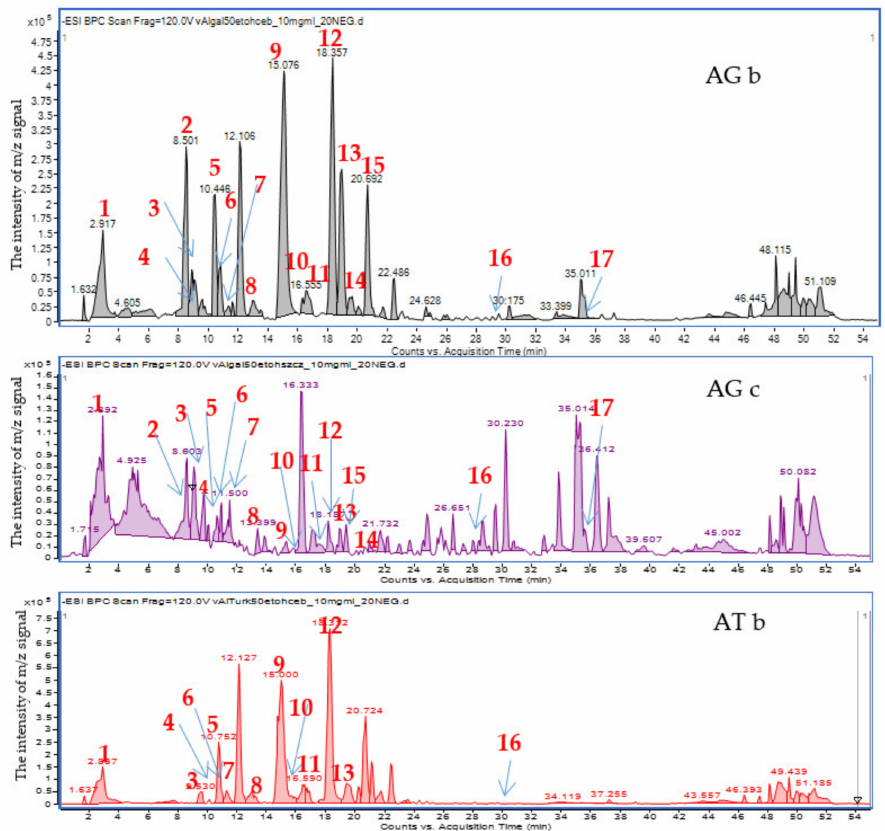
Figure 1. Mass chromatograms recorded in the negative ion mode for 50% ethanol extracts of Kazakhstani bulbs (top: Allium galanthum bulb extract ( AGb ), Allium galanthum chives extract ( AGc ), Allium turkestanicum bulb extract ( ATb